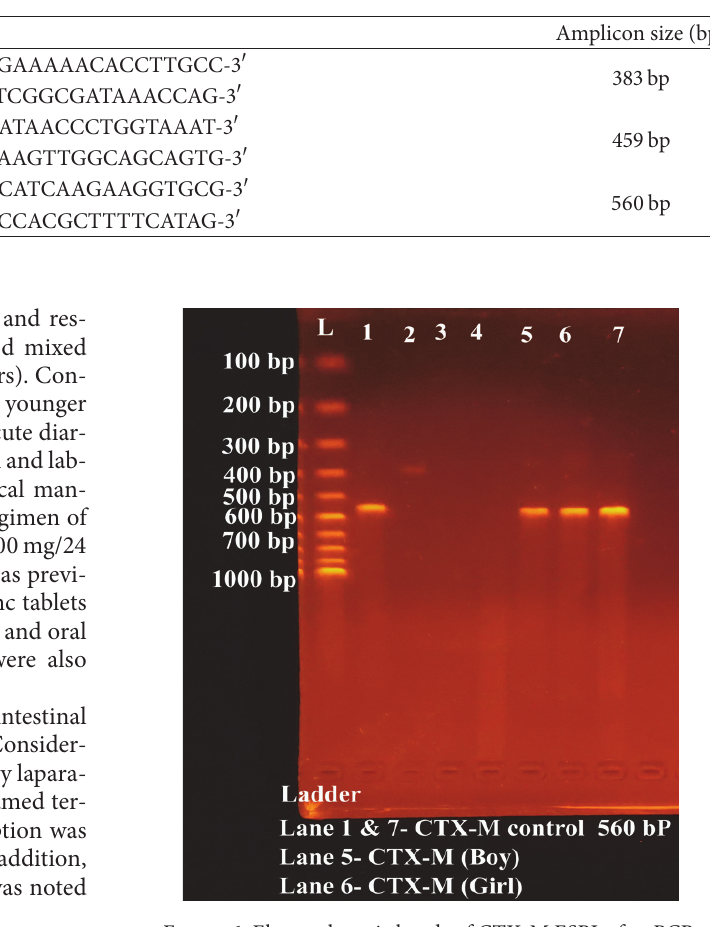
Figure 1: Electrophoretic bands of CTX-M ESBL after